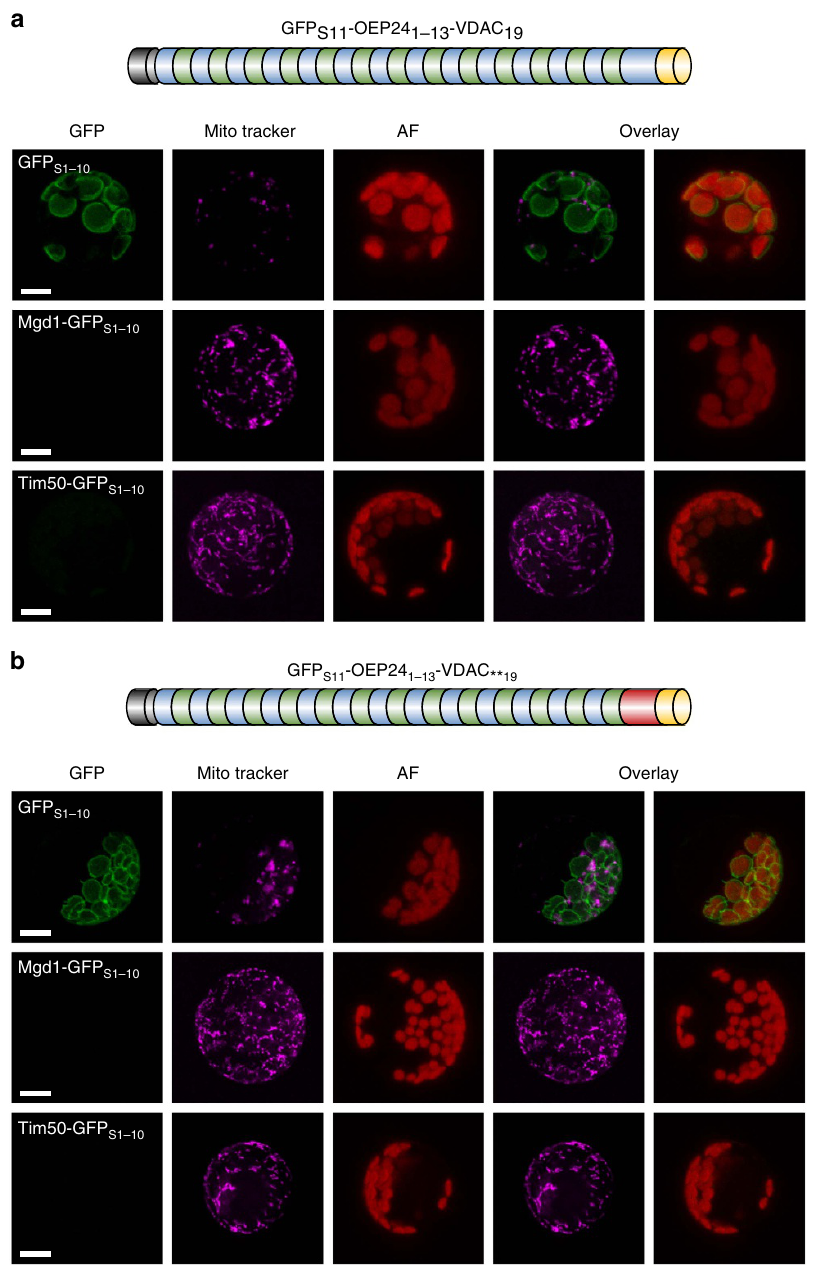
Figure 4 | The ultimate b -strand of atVDAC1 does not direct psOEP24 to mitochondria. ( a , b ) The last b -strand (GFP S11 -OEP24 1–13 -VDAC 19 ) ( a ) or the last b -strand and the last loop (GFP S11 -OEP24 1–13 -VDAC **19 ) ( b ) of psOEP24 were replaced by the corresponding regions of atVDAC1 and the resulting fusion proteins were co-transformed with the indicated reporter constructs into A. thaliana protoplasts. Signals and schemes are as in Fig. 3a. Scale bar, 10 m